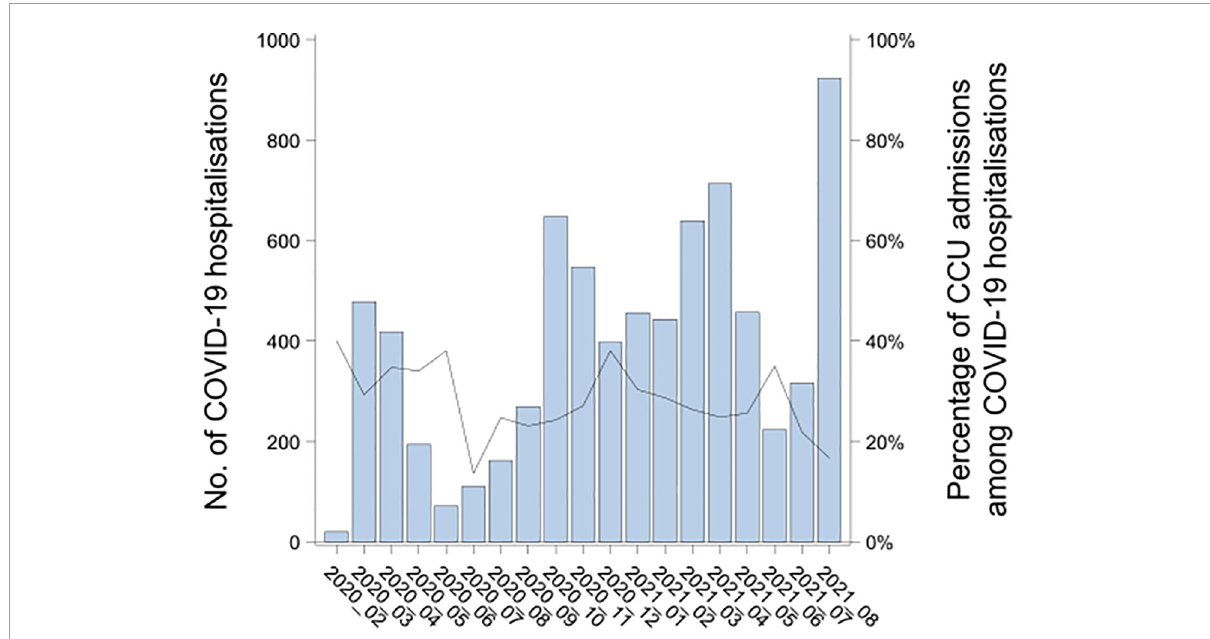
FIGURE6 Number of pediatric COVID-19 hospitalizations by month and percentage of COVID-19 hospitalizations in critical care units in France from February 2020 to August 2021. The bars give the number of COVID-19 hospitalizations per month. The black plain line gives the percentage of CCU admissions among the COVID-19